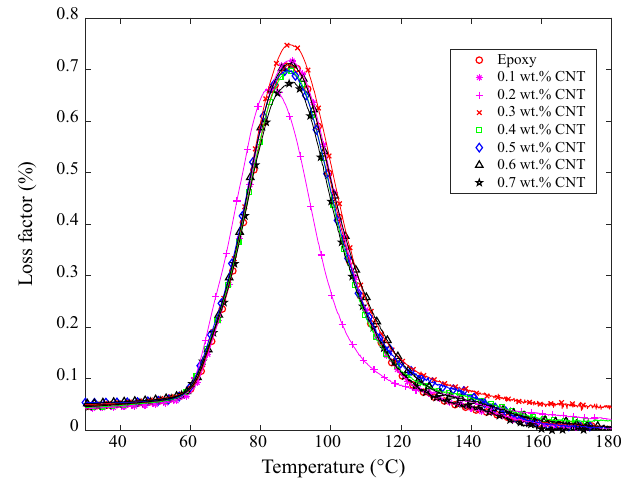
Figure 5: Temperature - dependent loss factor of CNT - reinforced composites by DMA tests.